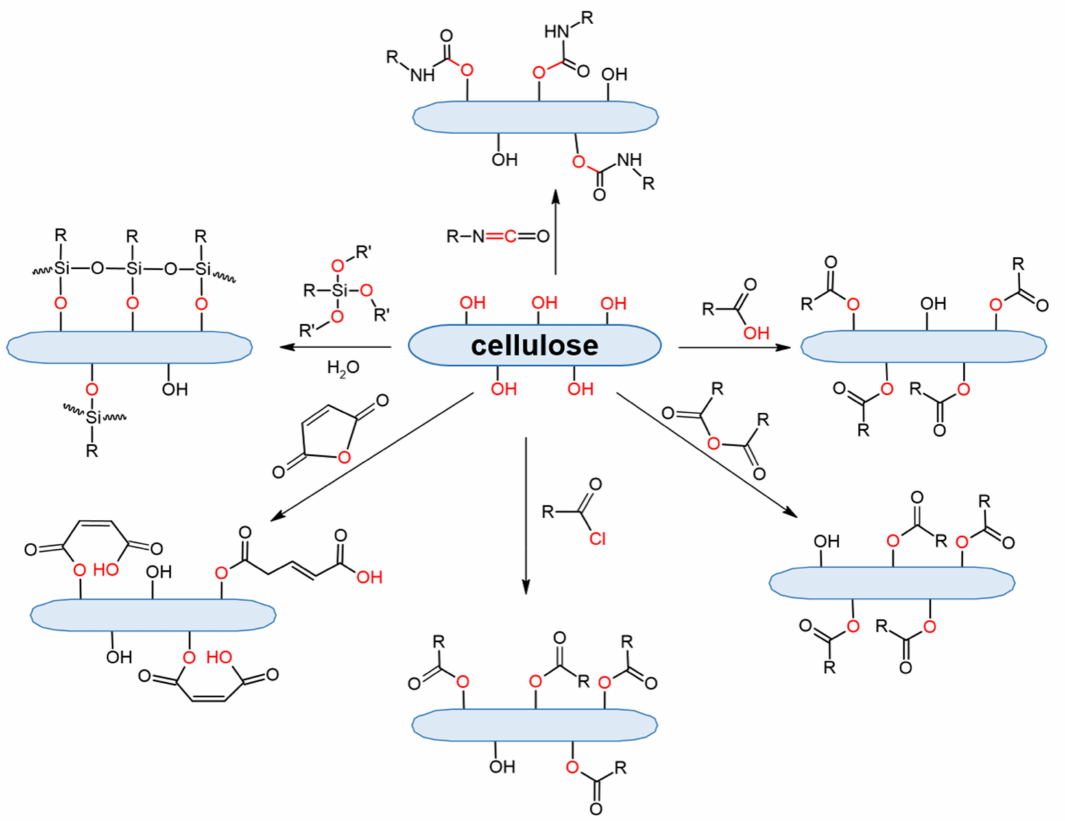
Figure 5. Scheme of cellulose-modification pathways with small molecules (esterification, acylation, silanization, modification with